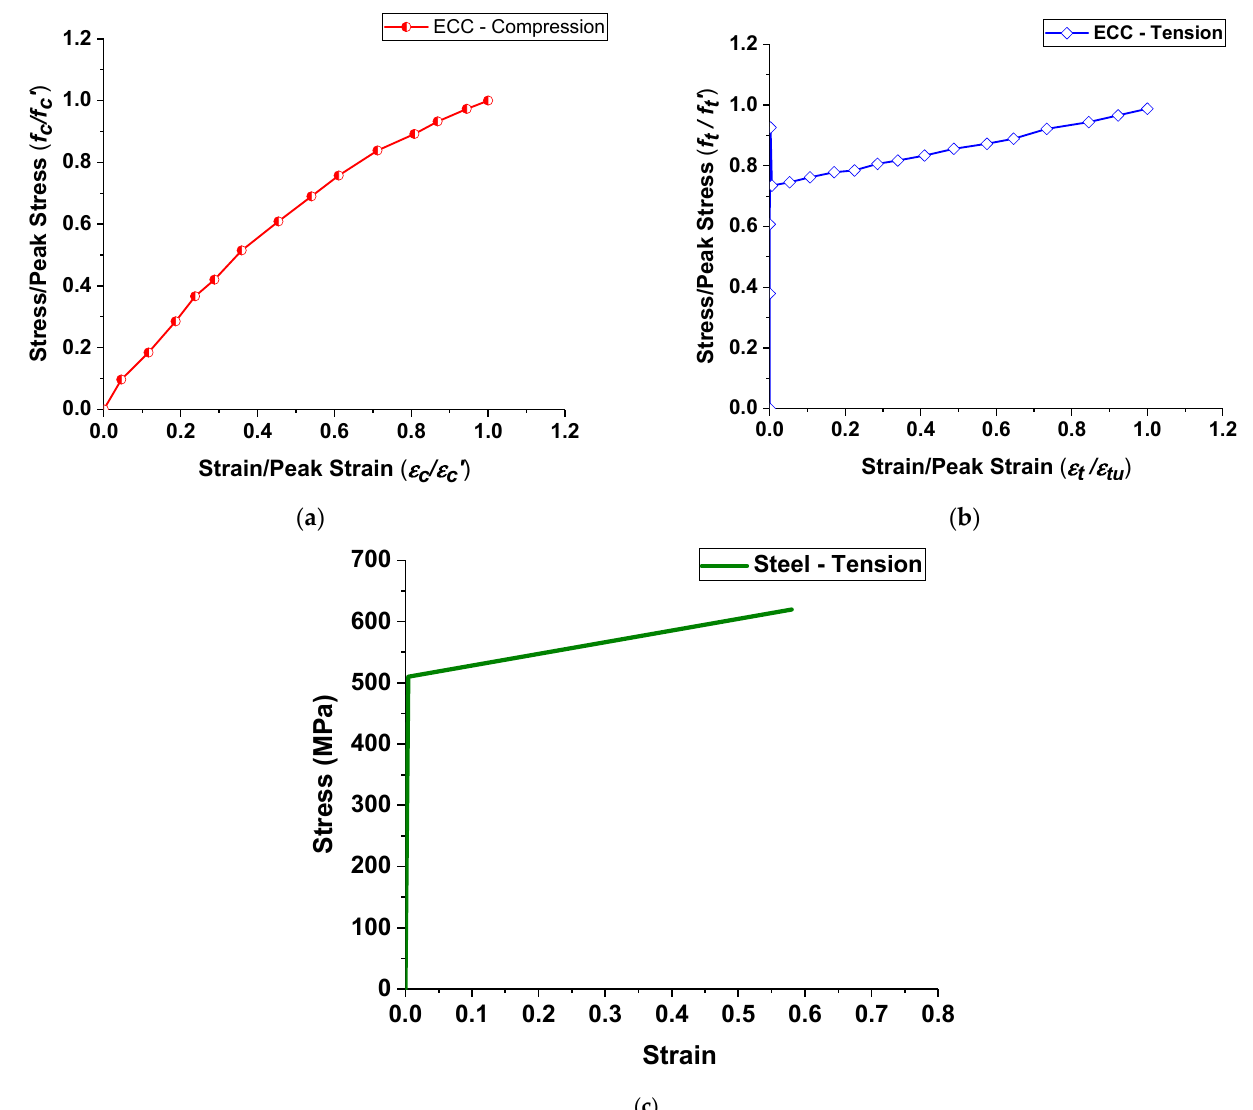
Figure 4. Material properties of ECC and steel rebars. ( a ) ECC in compression, ( b ) ECC in tension, ( c ) Steel reinforcement.